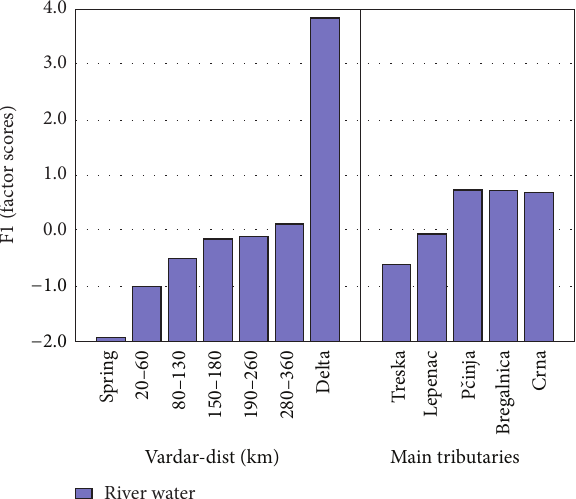
Figure 2: Factor 1 (factor scores) of river Vardar and main